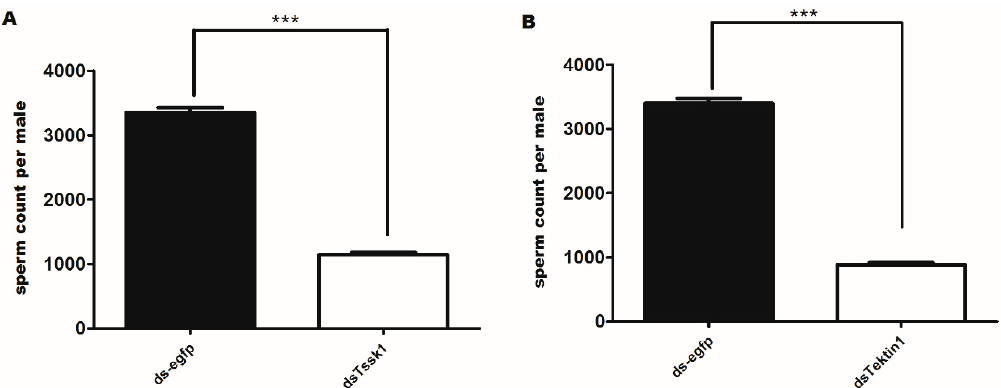
Figure 7. Reduced expressions of Tssk1 and Tektin1 in testis have affected the average number of spermatozoa. (A) Average number of spermatozoa in males treated with dsTssk1, compared to control (ds-egfp) group. (B) Average number of spermatozoa in males treated with dsTektin1 , compared to control (ds-egfp) group. The data were analyzed using T-test. *** indicates p < 0.001.